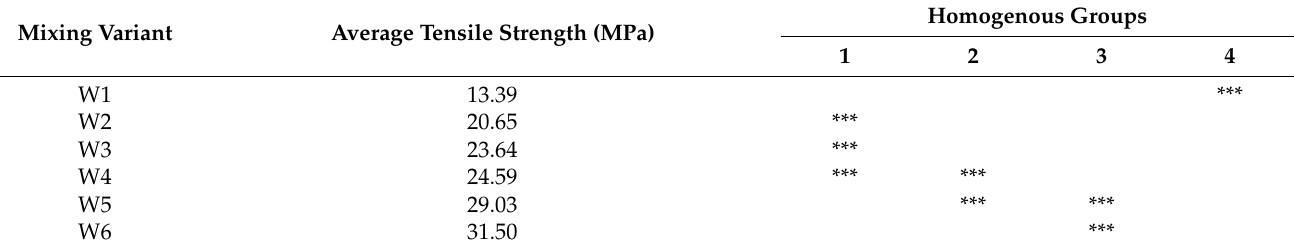
Table A5. Results of Tukey’s post hoc (HSD) tensile strength test for E57/Z-1/CaCO 3 /100:10:20 composition. Mixing Variant